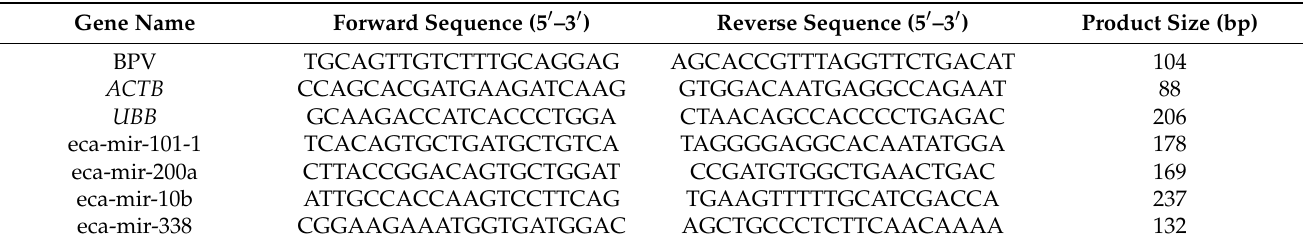
Table 1. qPCR primer sequences used in the